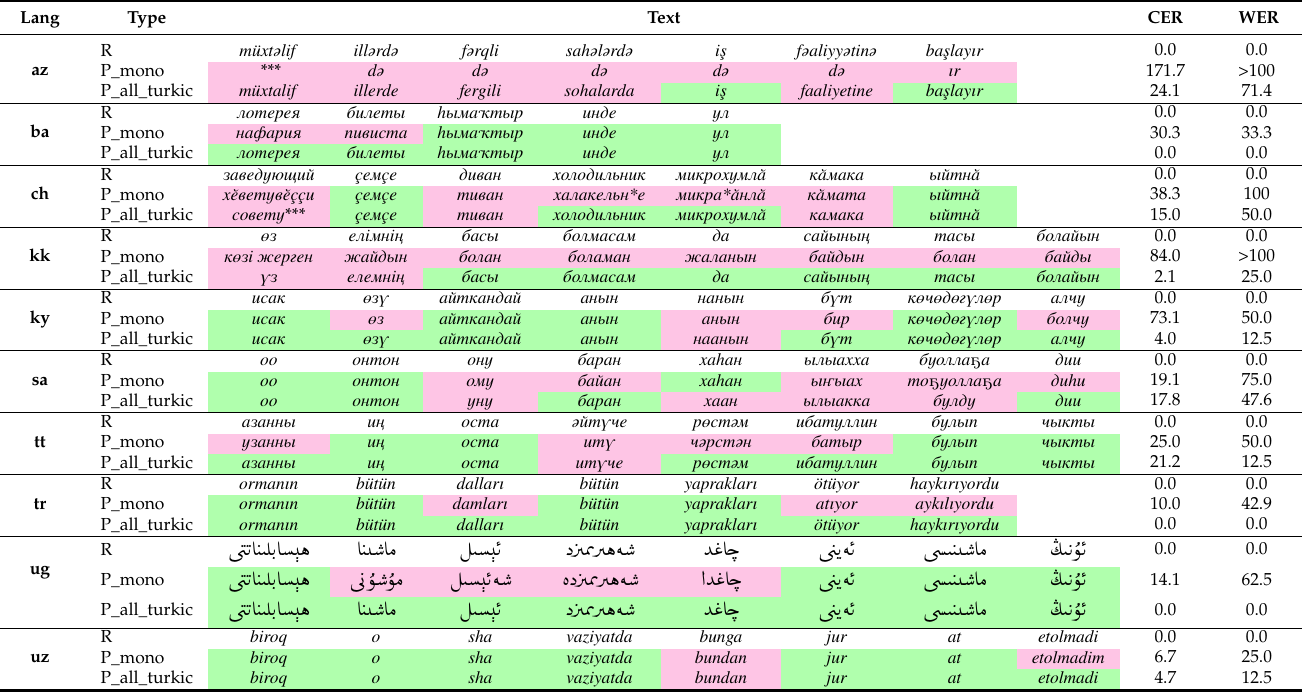
Table 8. Sample ASR results for monolingual models and the all_turkic model (R: